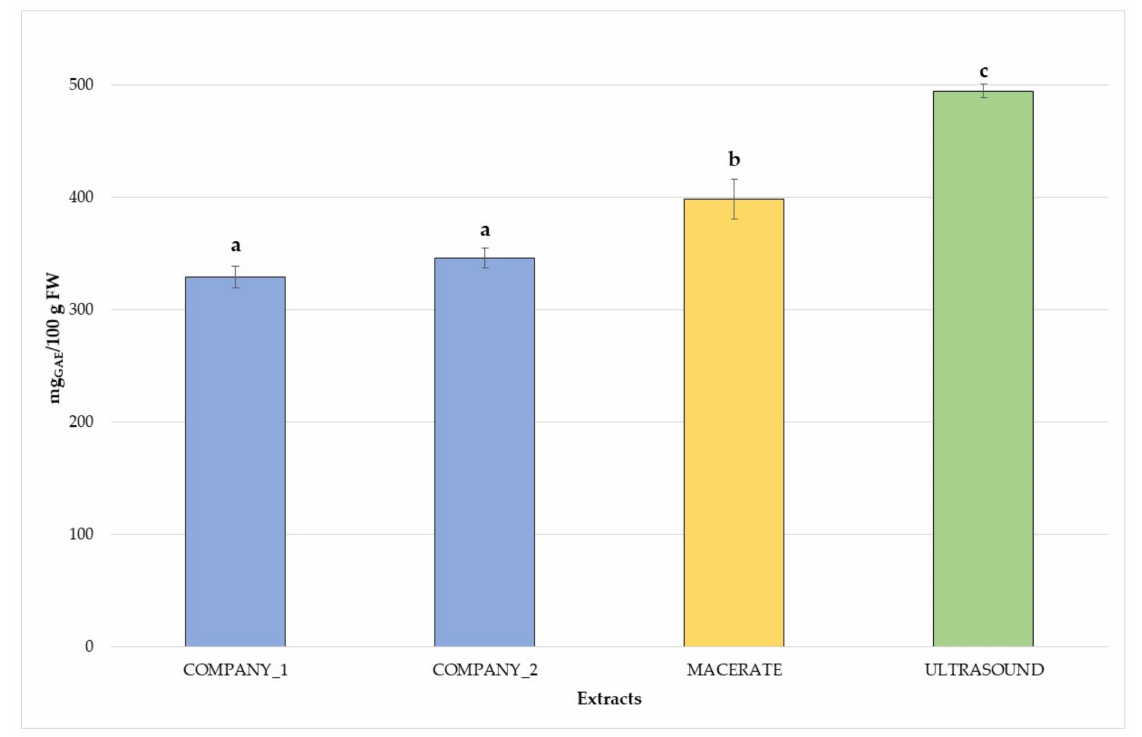
Figure 1. Total polyphenolic content of the analysed V. vinifera bud-extracts. Different letters for each extract highlight the significant differences at p < 0.05; blue—commercial bud-preparations, C1 and C2; yellow—traditional macerate, M; green—ultrasound extract, US.